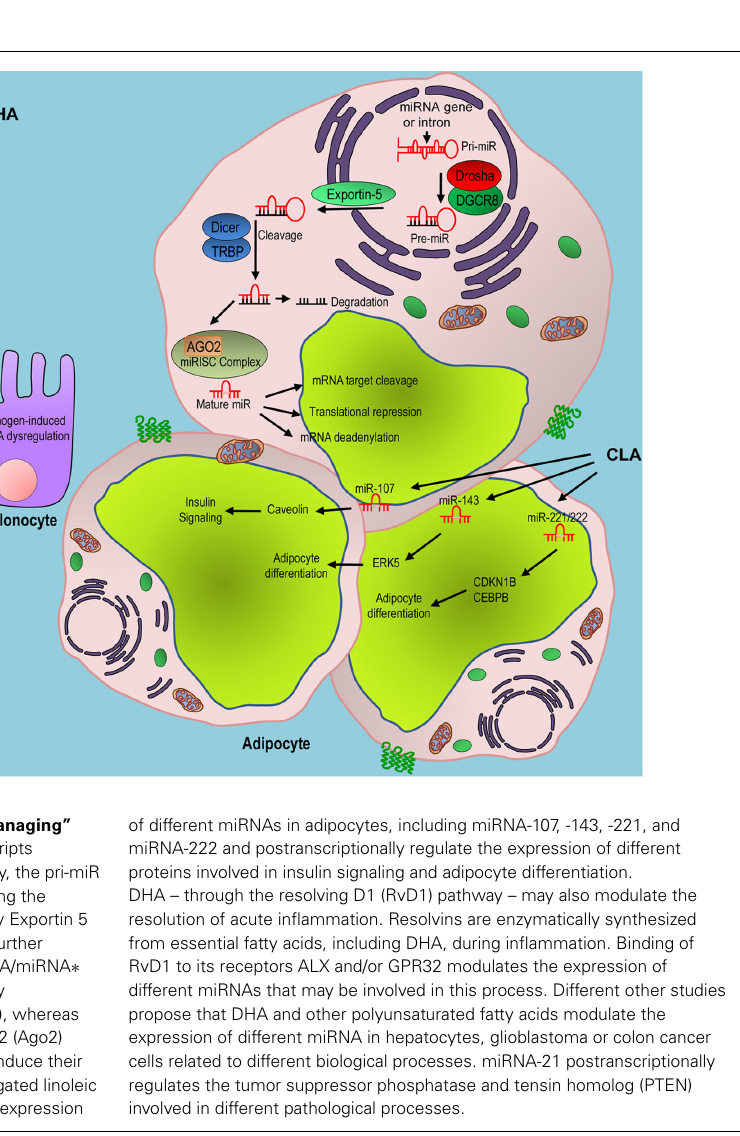
FIGURE 2 | Proposed role of essential fatty acids in “micromanaging” molecular actions. miRNAs are transcribed from specific transcripts generating a primary precursor (Pri-miR). In the canonical pathway, the pri-miR is processed by the family of RNase III enzyme Drosha, generating the precursor hairpin (pre-miR) which is exported to the cytoplasm by Exportin 5 protein. In the cytoplasm, the second RNase III enzyme (Dicer) further cleaves the Pre-miR, generating the double strand ∼ 20-bp miRNA/miRNA ∗ duplex. One strand of the miRNA/miRNA ∗ duplex is preferentially incorporated into the miRNA-induced silencing complex (miRISC), whereas the other strand (passenger or miRNA ∗ ) is degraded. Argonaute 2 (Ago2) containing miRISC bind by base-pair to their target mRNAs and induce their translational repression or deadenylation and degradation. Conjugated linoleic acid (CLA) supplementation has been proposed to modulate the expression